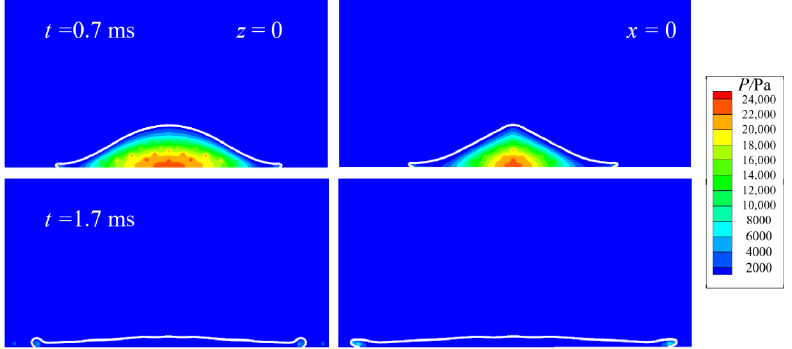
Figure 12. Pressure distribution in the cross-sectional area of z = 0 and x = 0 for AR = 0.56.